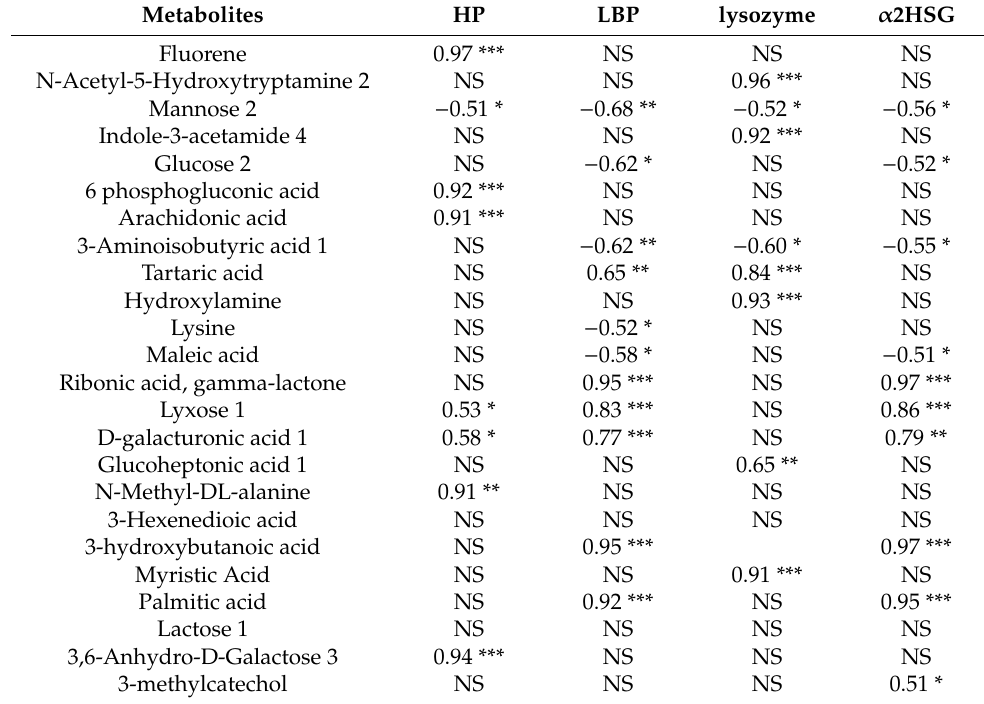
Table 3. Partial Pearson’s correlation between APRs and metabolites with correction of the treatment groups (HS and